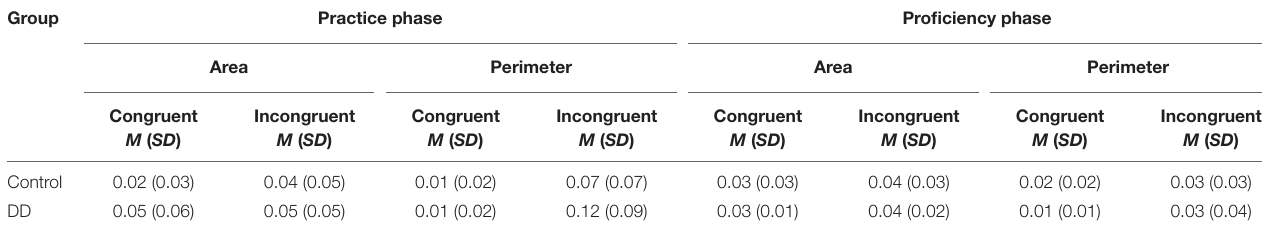
TABLE 3 | Mean error rates (in percentage) in area and perimeter tasks across different exposure phases of the two groups. Group